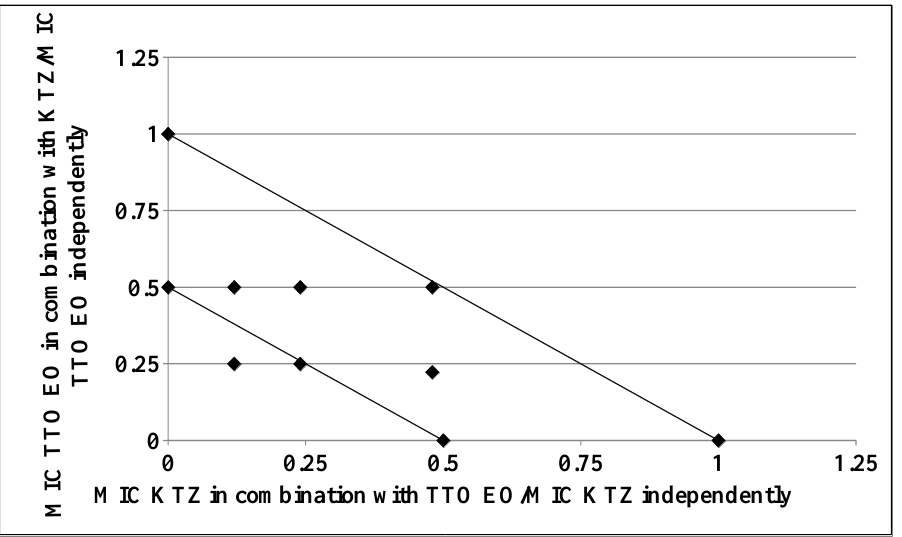
Figure 4. Isobologram of a synergistic interaction between TTO and KTZ against Trichophyton rubrum SL 171/13 strain. KTZ–FIC data are drafted on the x -axis, while TTO–FIC values are drafted on the y -axis.